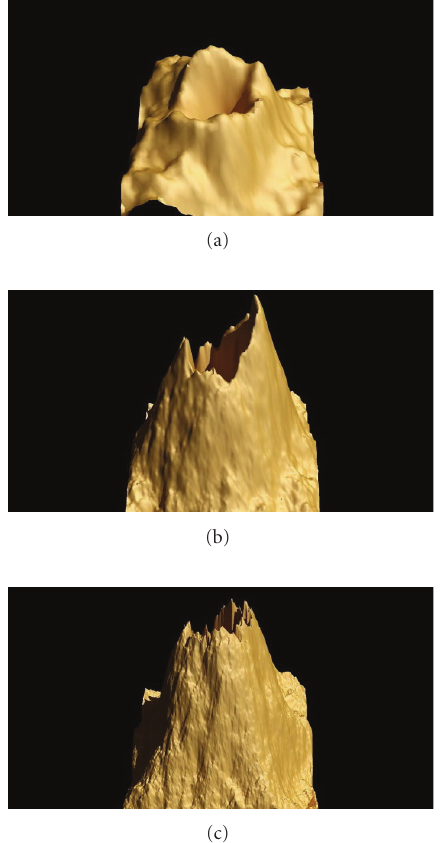
Figure 14: Mountains generated by TP in (6), with resolutions 50 × 50, 150 × 150, and 450 × 450.